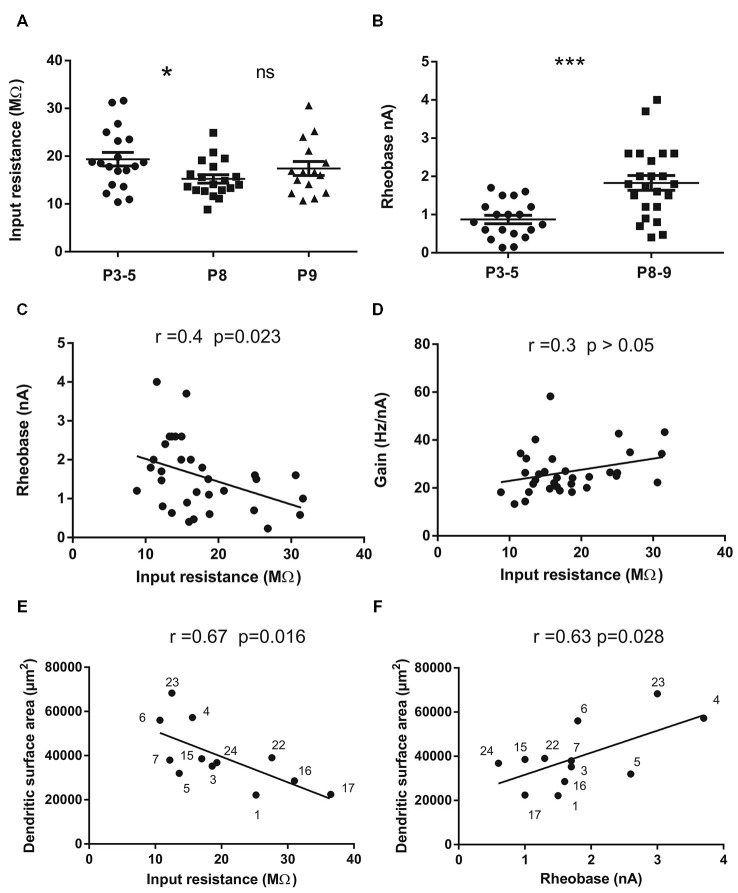
Input resistance (Rin) and rheobase of mouse lumbar motoneurons (n = 53) at different postnatal ages (P3 to P9) and correlations with total dendritic surface area in 12 motoneurons stained with neurobiotin. (A) Mean Rin significantly decreases between the groups P3–5 and P8 (p = 0.028, n = 19 in each group) and then stabilizes at P9 (n = 15). (B) the mean rheobase (minimum current injected into a neuron to elicit an AP in 50% of cases) increases in the same period of time (p = 0.0033, n = 19 for P3–5 and n = 31 for P8–9). (C) significant negative correlation exists between rheobase and Rin in the whole population (n = 32); (D) no significant correlation was found between the Rin and the gain of the motoneurons (n = 32). The gain is the slope of the F-I curves measured in the steady state of the discharge firing elicited during rectangular pulses of currents. (E,F) significant correlations between Rin (E) rheobase (F) and the total dendritic surface area measured using 3D reconstructed motoneurons with neurolucida. Each motoneuron is numbered so that it can be identified from previous publications Amendola and Durand (2008) for Mn n° 1–7 and Filipchuk and Durand (2012) for Mn n° 15, 16, 17. The morphologies of motoneurons n° 22, 23 and 24 were not previously published. The largest motoneurons tend to have the lowest Rin and the highest rheobase. Horizontal bars indicated mean ± sem in the scatter plots of A and B. For statistical significance nonparametric permutation or mann-whitney exact tests and Pearson’s correlation test were used. *p < 0.05; **p < 0.01; ***p < 0.005. Non-significant (ns) p > 0.05.